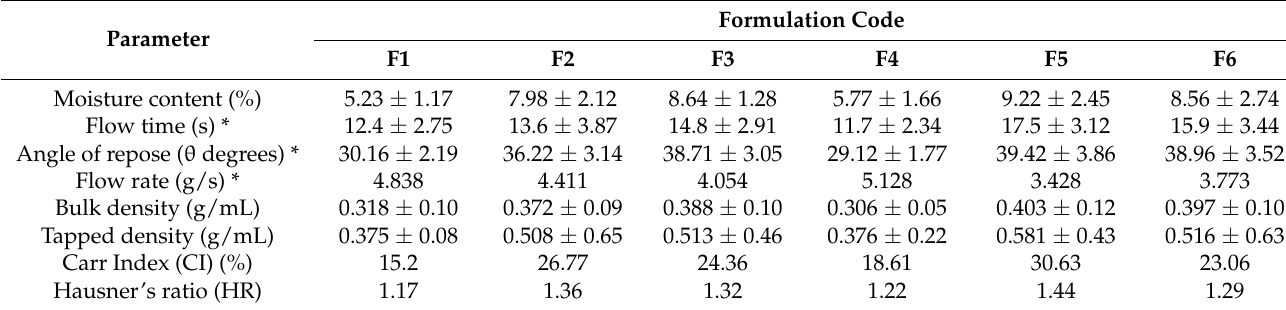
Table 4. Precompression parameters for the direct compression